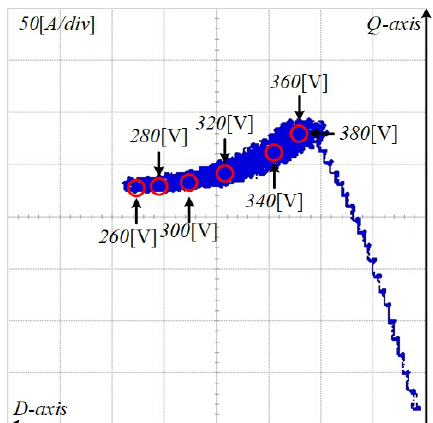
Figure 8. d -/ q -axis currents trajectory for constant torque control with variable DC-link voltage (DC-link voltage of 380 V to 260 V, constant motor speed of 3000 rpm, and torque reference of 130 [Nm]).